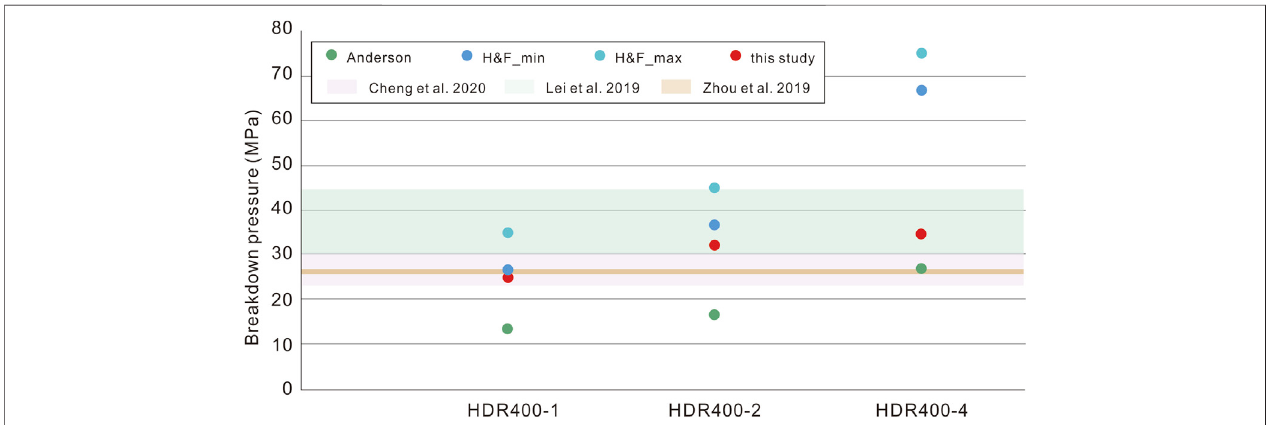
FIGURE 14 | Comparison between measured HF breakdown pressure and relative literature results in Qinghai.